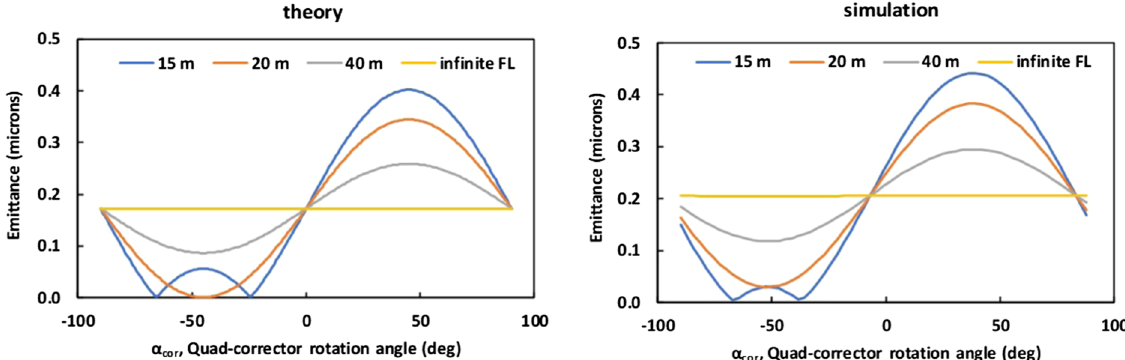
FIG. 6. Comparison of the transverse coupled emittance for a q 1 s as computed by Eq. (23) (left) and a numerical simulation (right). The configuration and parameters are given in Fig. 5. The emittance growth is for quad1 with a fixed focal length of 50 m and quad-corrector focal lengths of 15, 20, 40, and infinite meters. The beam energy is 6 MeV. The 15-, 20-, and 40-m focal lengths correspond to 21.5, 14.3, and 5.4 G, respectively, integrated